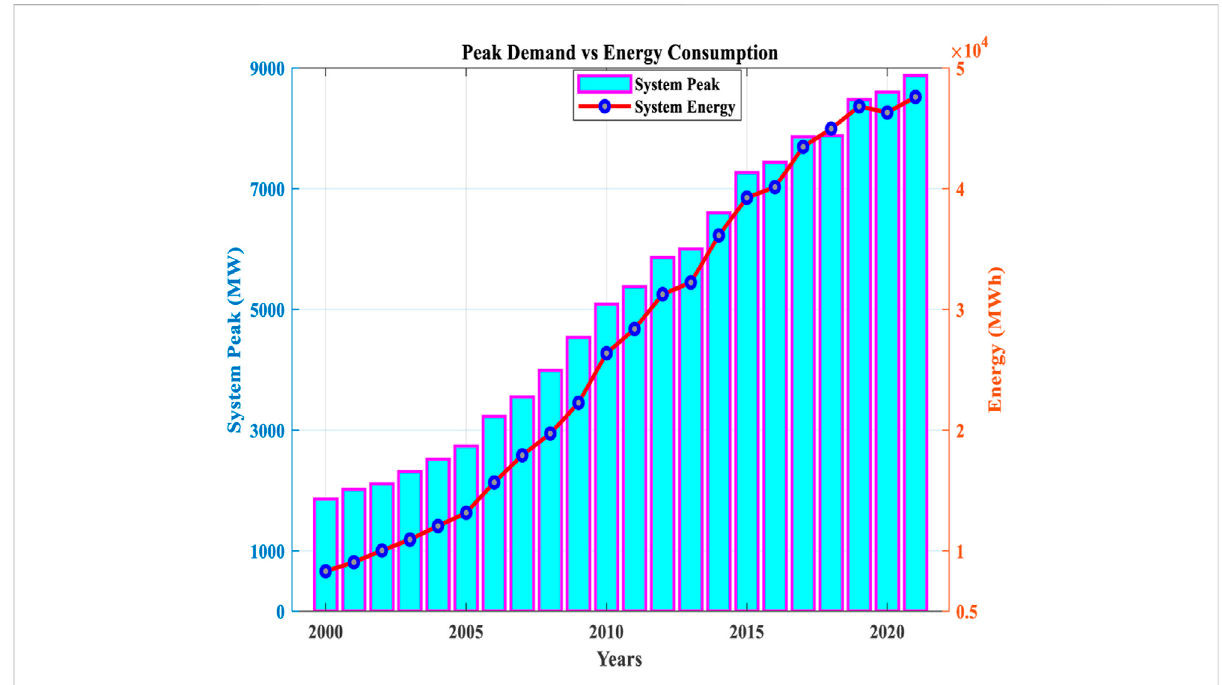
FIGURE 5 Historical peak demand and annual energy consumption from 2000 to